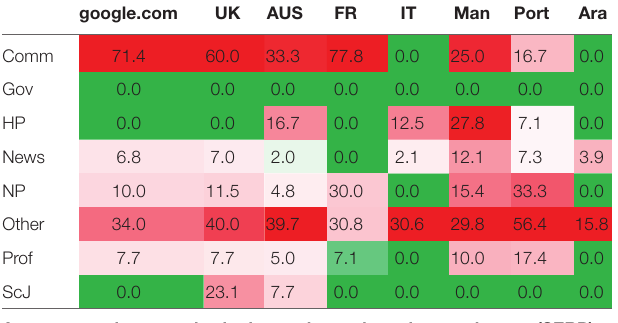
Table 6 | Frequency of vaccine-negative webpages in each typology. google.com